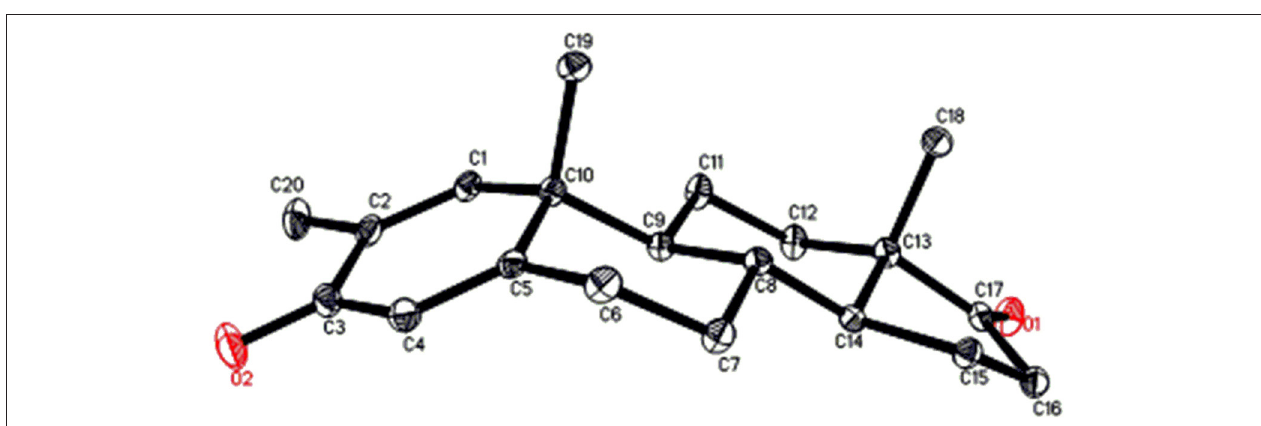
FIGURE 6 | Computer-generated ORTEP drawing of final X-ray model of compound 1 . Color codes: carbon, black; oxygen, red.